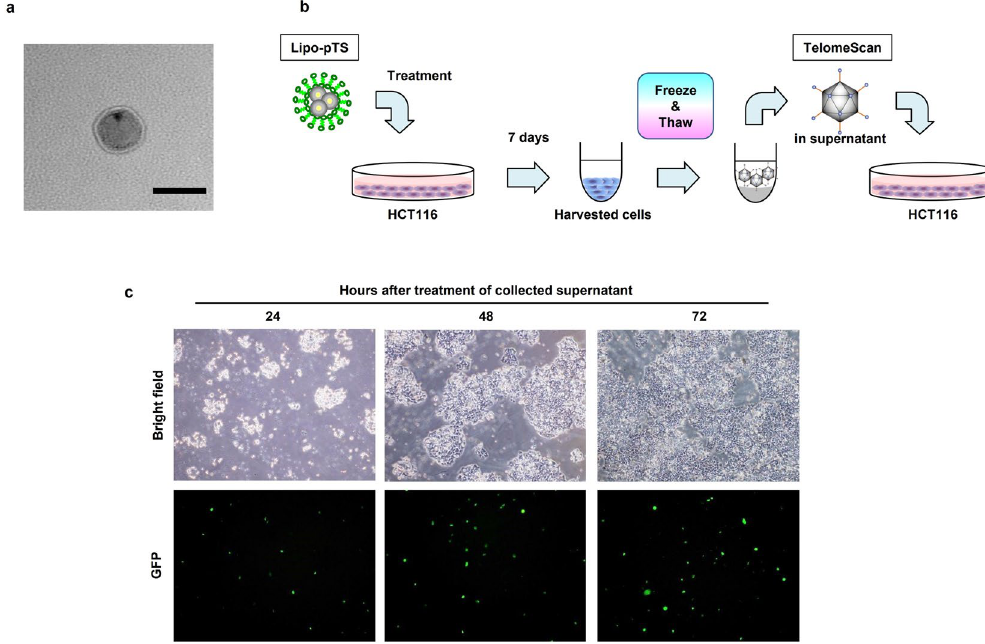
Figure 1. Characterization of Lipo-pTS. ( a ) Lipo-pTS seen on transmission electron microscopy. Scale bar, 50 nm. ( b ) The graphic shows the steps of the experiment to check the production of viable adenoviruses through the freeze-thaw process by which viable adenoviruses are isolated from the inside of cells. Briefly, HCT116 cells harvested at 7 days after Lipo-pTS treatment are subjected to a freeze-thaw process, and other HCT116 cells are treated with the supernatant collected by the freeze-thaw process. ( c ) HCT116 cells cultured for 24, 48, and 72 hours after the steps described in ( b ) are examined microscopically to check GFP expression. Note that GFP spots show successful production of viable oncolytic adenoviruses after Lipo-pTS treatment of HCT116